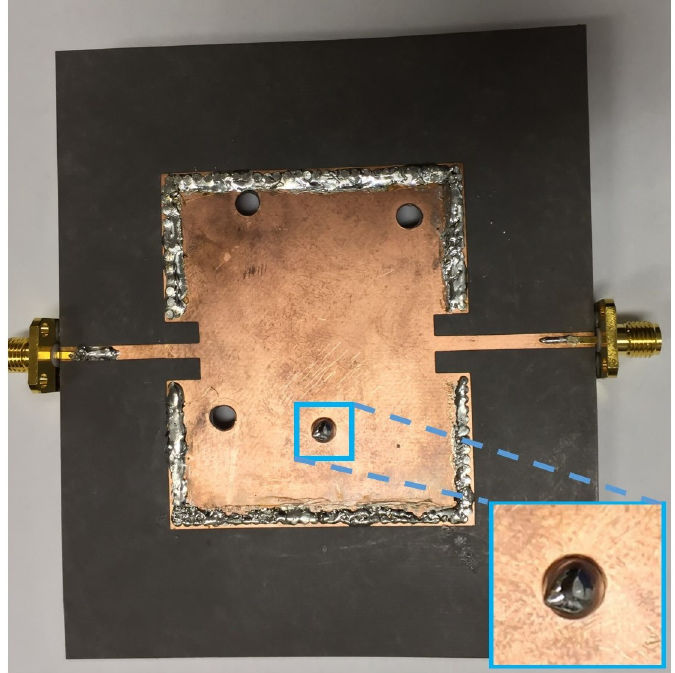
Figure 5. Photograph of the fabricated prototype at state 2 (0001). The magnified inset shows the liquid metal (LM)-filled channel after injecting eutectic gallium indium (EGaIn) into the channel 4.